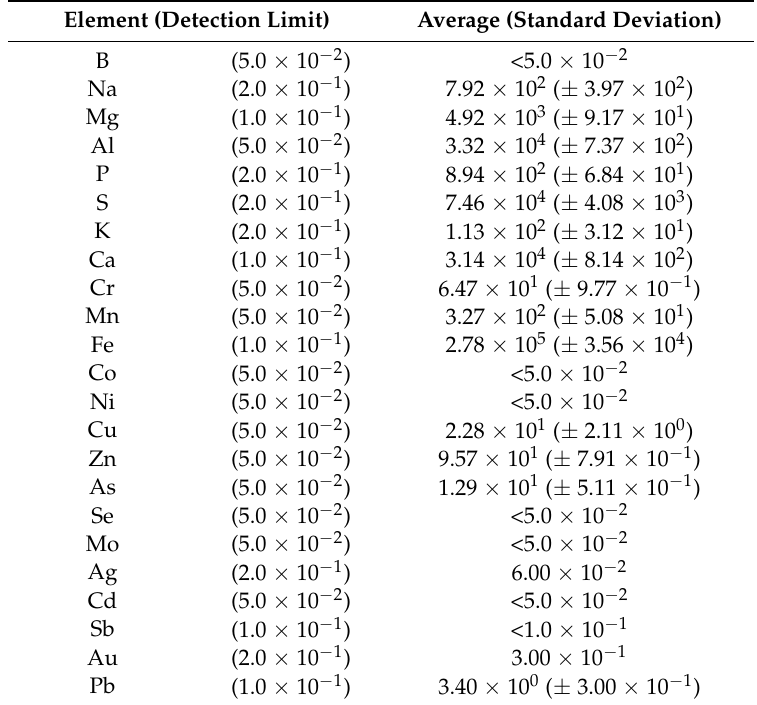
Table 1. The concentration ( µ g g − 1 ) of elements from TIFs based on inductively coupled plasma–mass spectrometer (ICP-MS) analysis. See Supplemental Table S1 for detailed values for calculating average and standard deviation